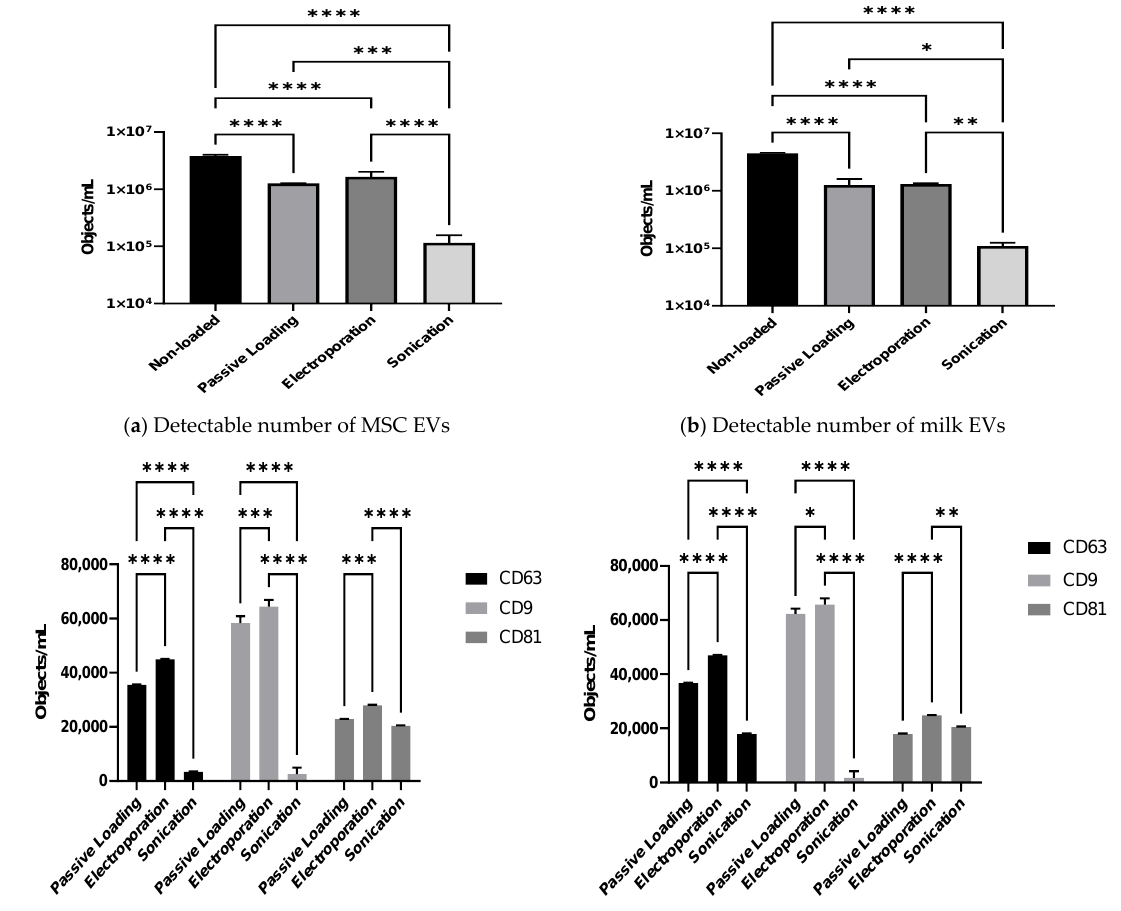
Figure 5. MSC EVs and milk EVs loaded with Dox using passive and active loading approaches were analysed by IFCM to investigate the effect of loading on total detectable EV-like objects and representative EVs surface proteins. Total detectable number of EV-like objects/mL in non-loaded versus Dox-loaded ( a ) MSC EVs and ( b ) milk EVs are presented. Further, the results are presented as a comparison of the number of CD63+, CD9+, and CD81+ objects/EVs in samples in passive loaded and active loaded ( c ) MSC EVs and ( d ) milk EVs. Results are mean from n > 3 ± SEM biological repeat experiments. Statistical analysis was done through 2-way Anova; * represents p value <